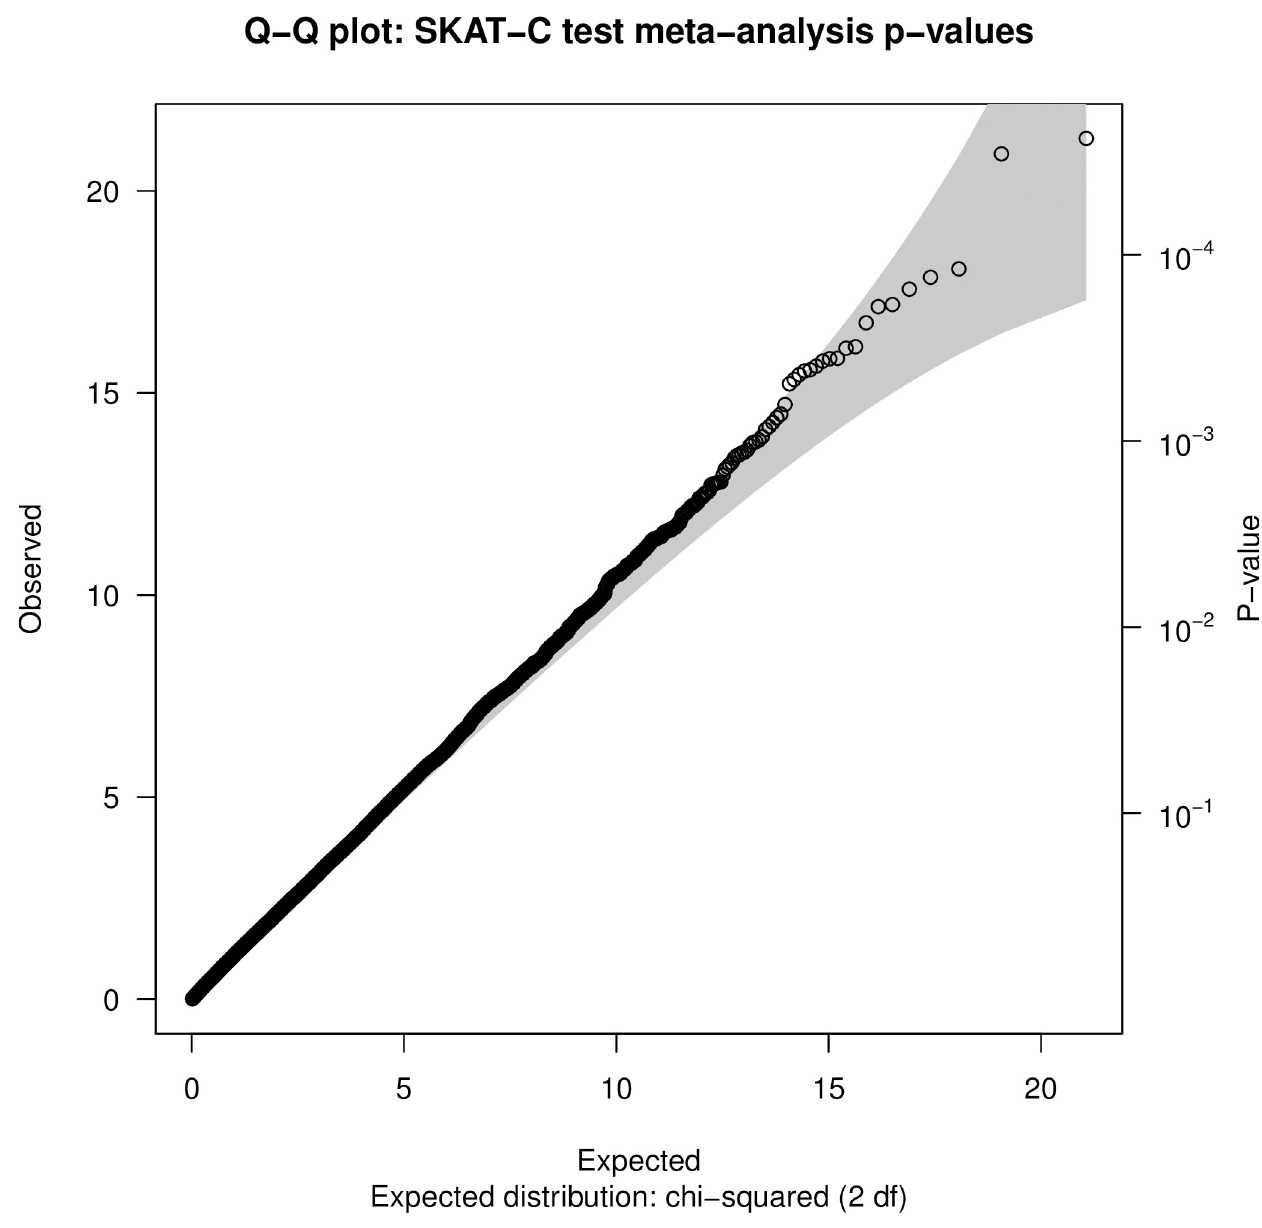
Fig 3. Quantile-quantile plot of SKAT-C test gene-level meta-analysis p-values.